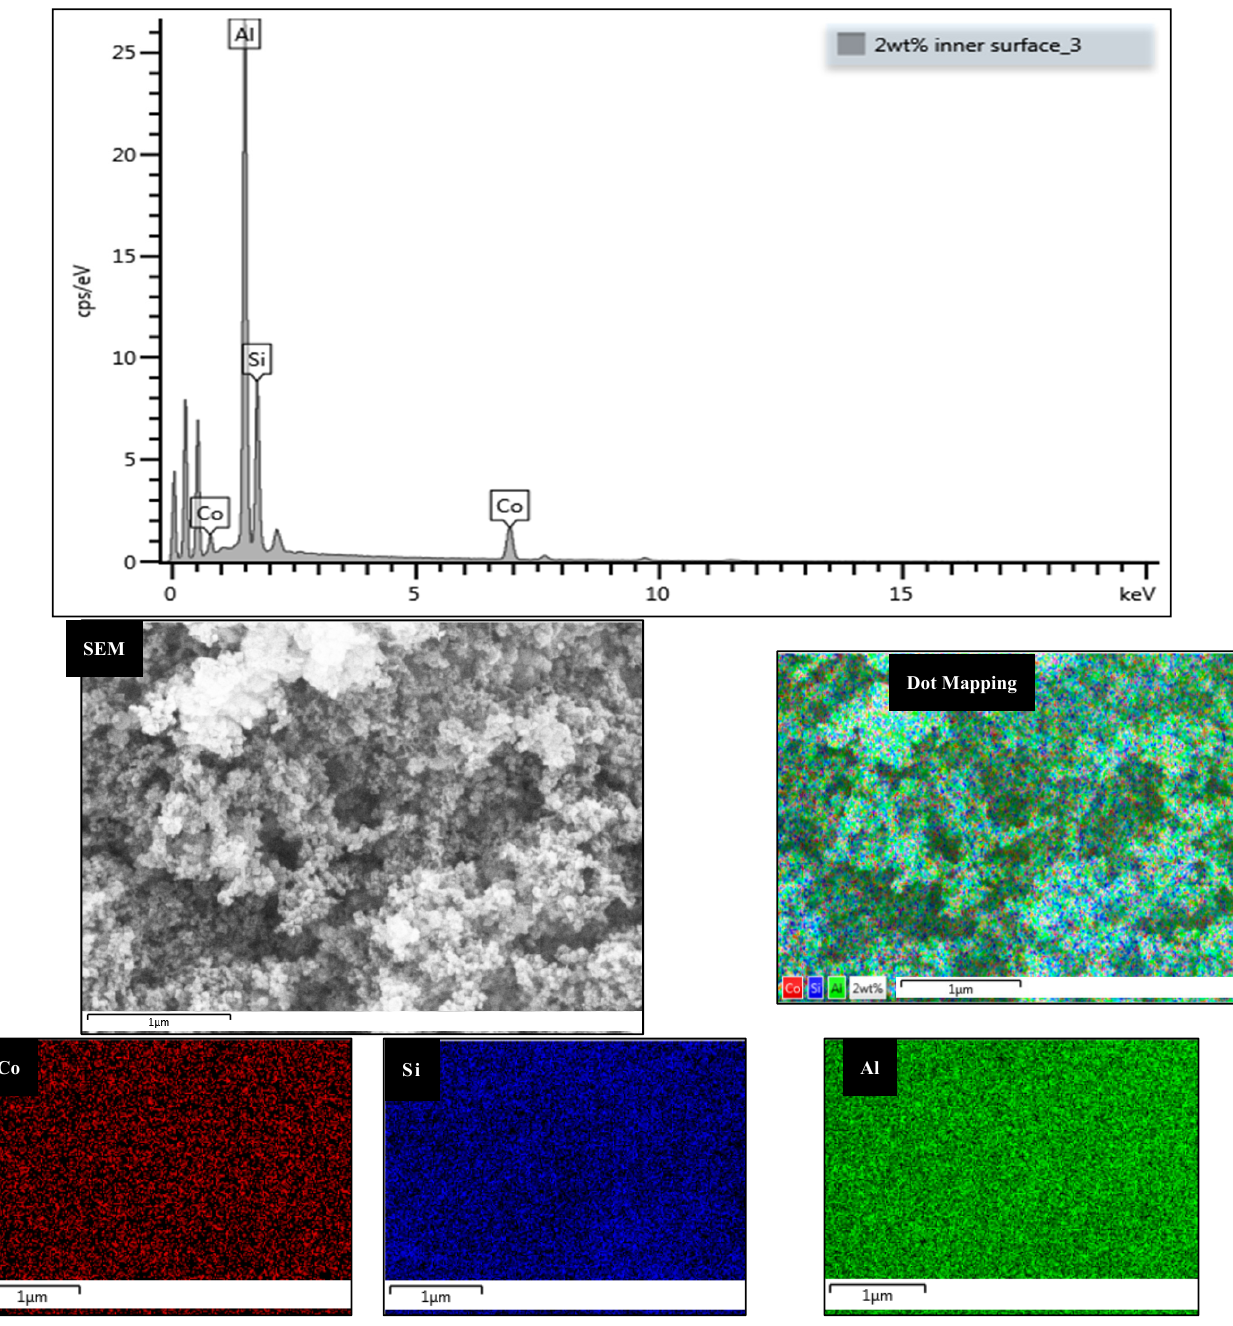
Figure 19. EDX dot mapping analysis of the surface of a used 2 wt% Co catalyst.